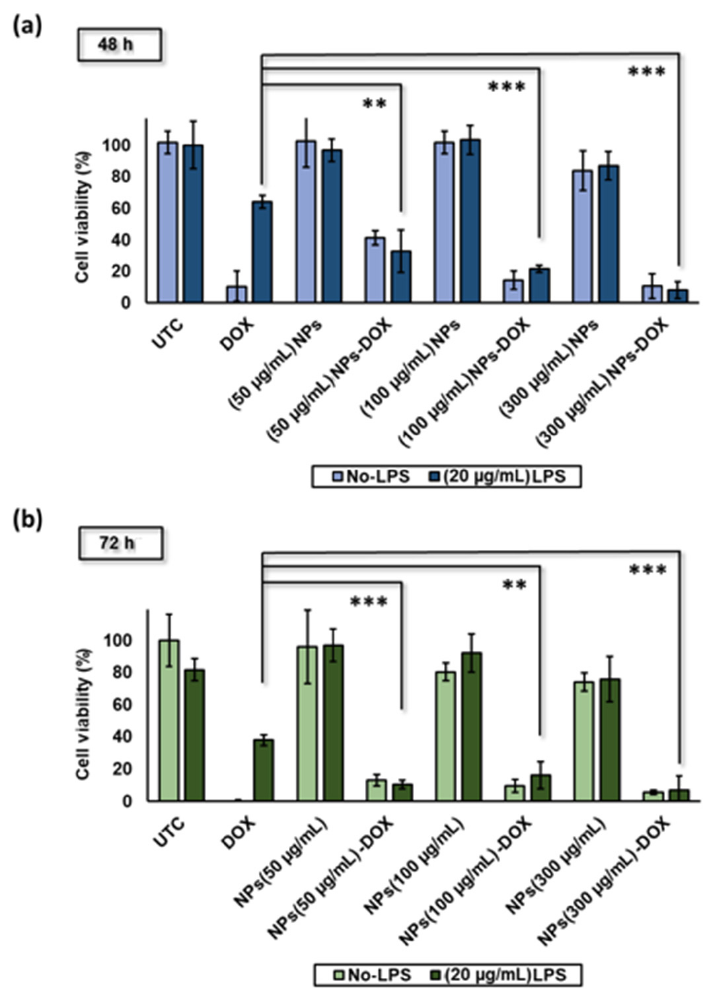
Figure 4. ( a , b ) Cytotoxicity of α 1 -acid glycoprotein-conjugated hyaluronic acid nanoparticles (AGP- HA NPs) at 48 h and 72 h incubation time using a CCK-8 kit, and LPS mediates DOX-resistance in MDA-MB-231 cells at various concentrations of α 1 -acid glycoprotein-conjugated hyaluronic acid nanoparticles (AGP-HA NPs) (50, 100, and 300 µ g/mL) at 48 and 72 h incubation time All data presented in averages and standard deviations from at least three independent experiments. Statistical analysis was determined using Student’s t -test (*** p < 0.001, ** p < 0.01). 3.5. Cellular Uptake and Localization of the AGP-HA NPs + DOX in MDA-MB-231